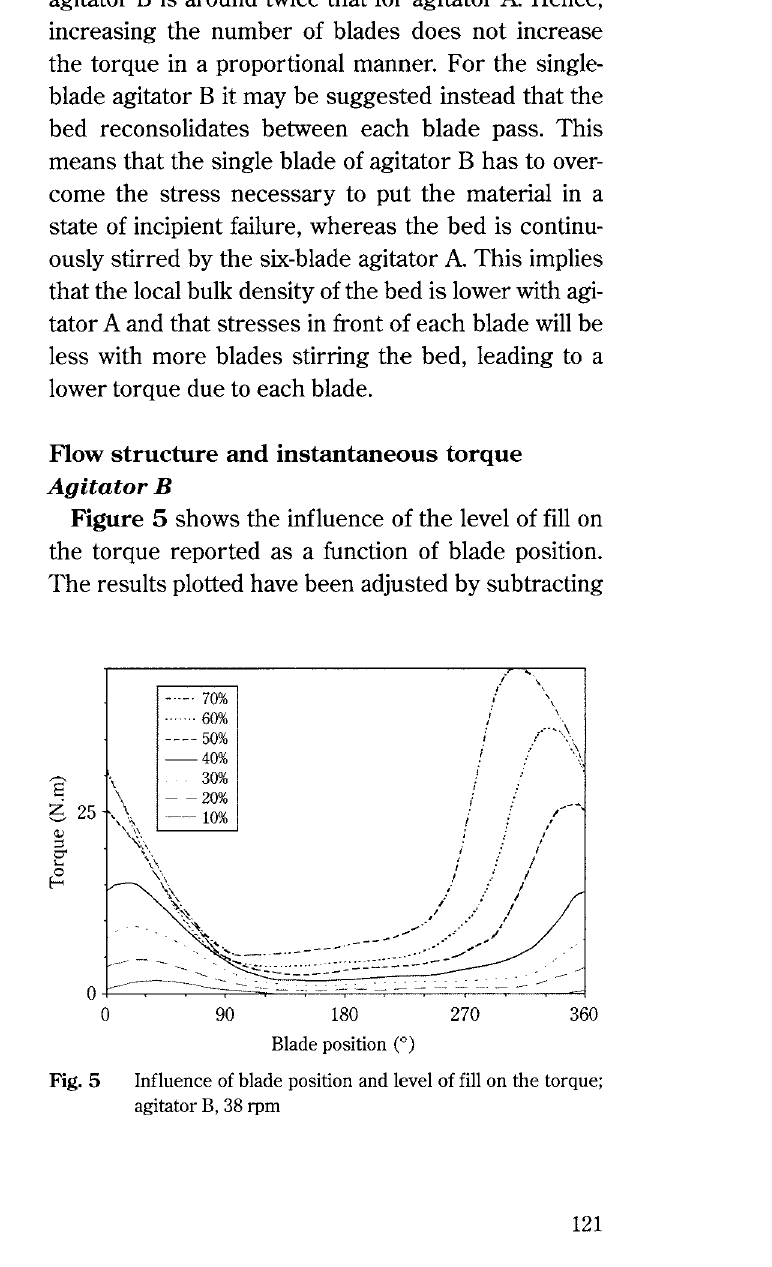
Fig. 5 Influence of blade position and level of fill on the